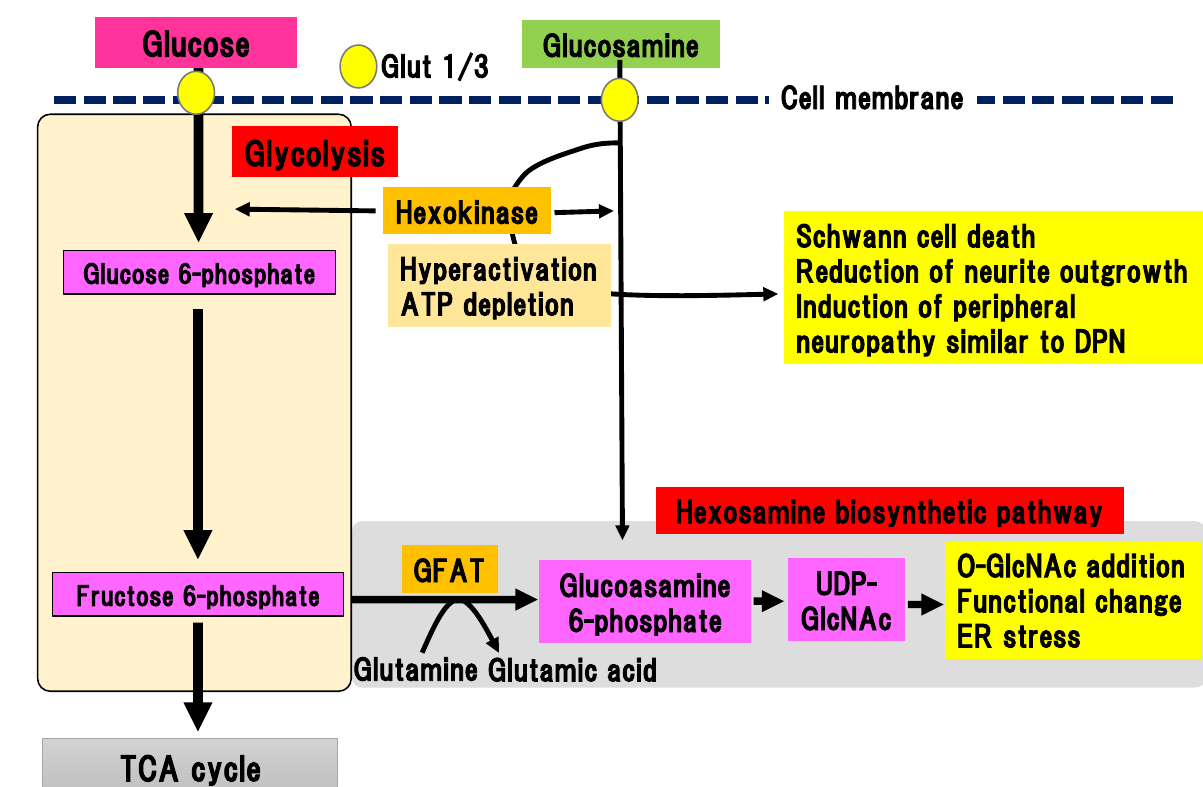
Figure 5. Hexosamine biosynthetic pathway and glucosamine pathway. Fructose 6-phosphate is converted to glucosamine 6-phosphate by glutamine-fructose-6-phosphate aminotransferase (GFAT). Glucosamine 6-phosphate is converted to uridine diphosphate- N -acetylglucosamine (UDP-GlcNAc), which can bind to serine/threonine residues in proteins via O-linked-glycosylation. Extracellular glucosamine is transported into the cytosol by Glut 1 or Glut 3. Incorporated glucosamine is initially metabolized to glucosamine 6-phosphate by hexokinase, consuming ATP. Glucosamine 6-phosphate is used in the hexosamine biosynthetic pathway. ER, endoplasmic reticulum; GFAT, glutamine-fructose-6-phosphate aminotransferase; Glut, glucose transporter; TCA cycle, tricarboxylic acid cycle; UDP-GlcNAc, uridine diphosphate (UDP)- N